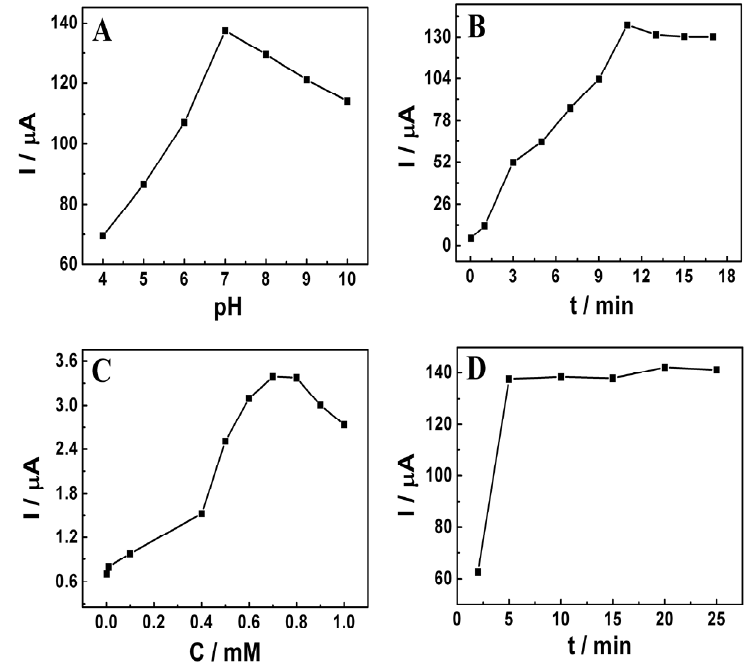
Figure 2. ( A ) Relationship between peak current and external solution pH; ( B ) Effect of accumulation time on the oxidation peak current of 20 μ M NP; ( C ) Influence of CTAB concentration on the oxidation peak current of 20 μ M NP; ( D ) Effect of modification time on the oxidation peak current of 20 μ M